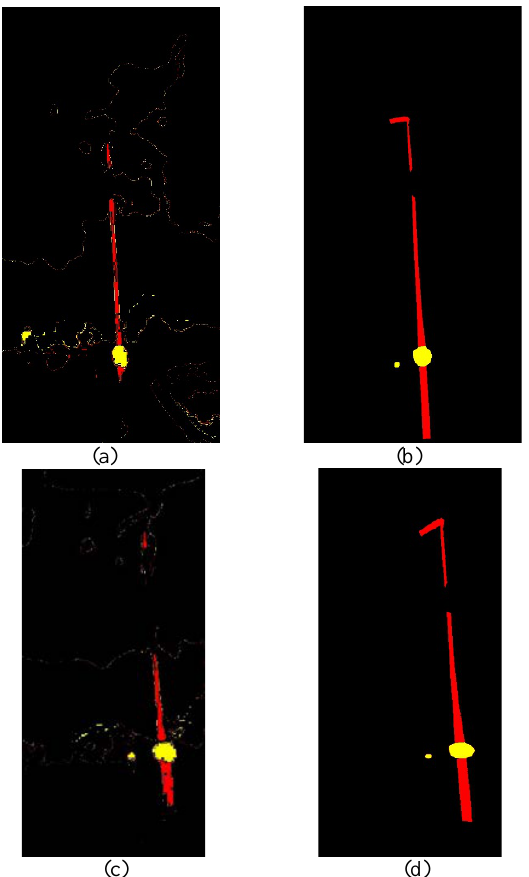
Figure 10. Predictions of pre-trained FCN model. (a) (b) The predictions and labeled ground truth of panoramic images. (c) (d) The predictions and labeled ground truth of transformed images.